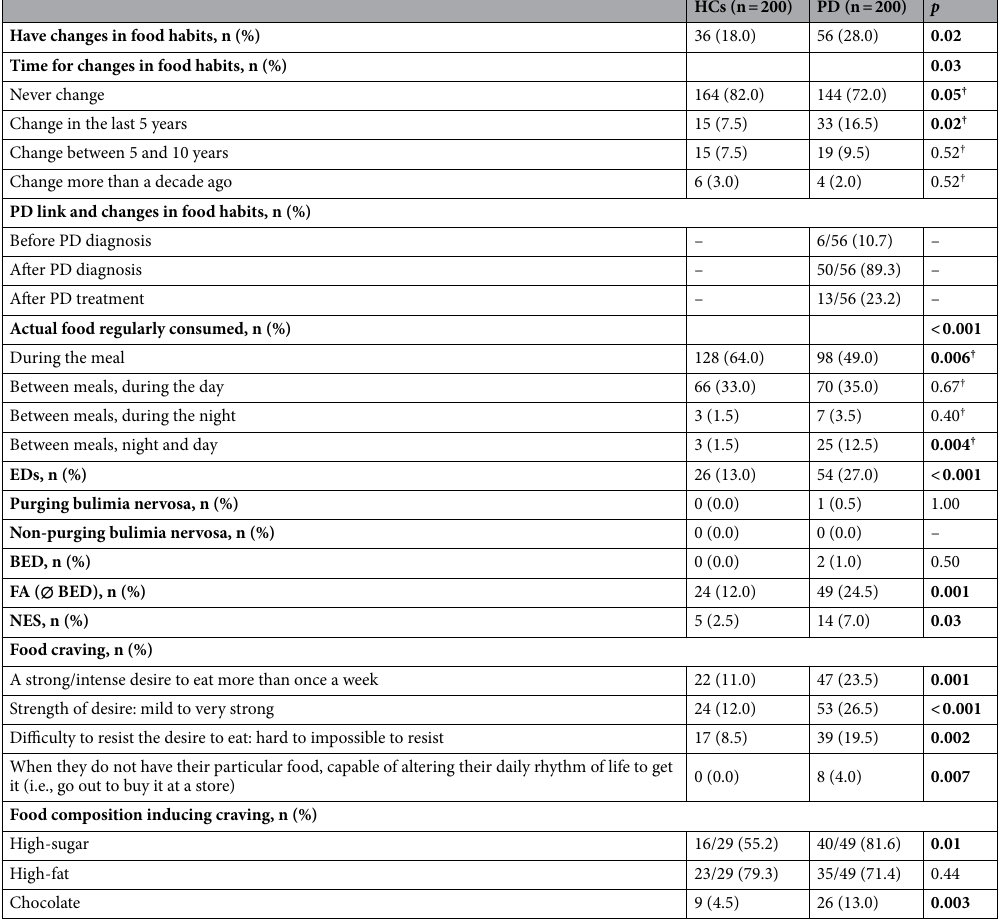
Table 2. Eating disorders in the HC and PD groups (n = 400). Bold values indicate statistical significance ( p < 0.05). BED binge eating disorder, FA food addiction, HC healthy controls, NES night eating syndrome, PD Parkinson’s disease, EDs eating disorders, ∅ : without. † Post-hoc